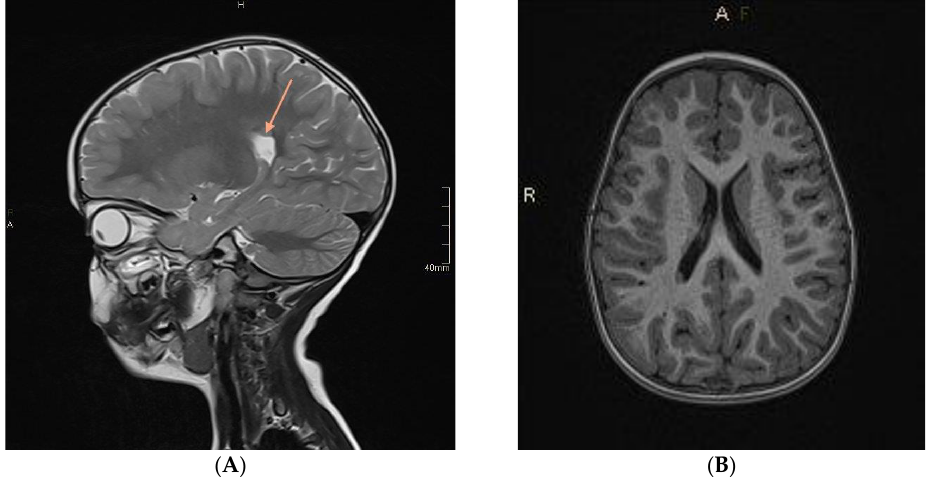
Figure 4. Head MR imaging (T2 − weighted ( A ) and T1 − weighted ( B ) images) of a 3 − year − old boy after the third episode of seizures. MR examination showed a single focus of heterotopia. Source: own study.